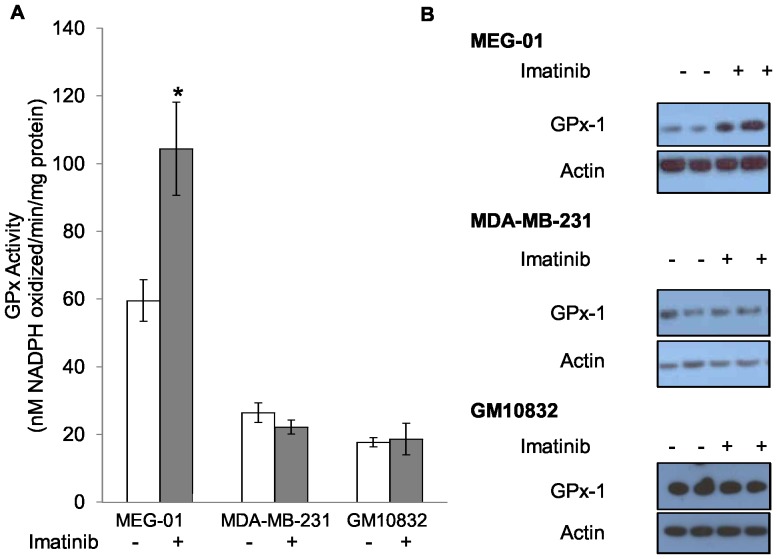
GPx-1 is increased in MEG-01, but not MDA-MB-231 and GM10832, following imatinib treatment.The effect of imatinib on GPx enzyme activity (A) and GPx-1 protein (B) in MEG-01, MDA-MB-231 and GM10832 is shown. GPx activity was increased 2-fold, and protein increased 4-fold (P<0.01) by 300 nM imatinib treatment in MEG-01. GPx-1 activity and protein levels did not change following imatinib treatment of MDA-MB-231 (500 nM imatinib) and GM10832 (300 nM). Data presented in A is the result of three independent experiments * = P<0.001. Error bars indicate S.D.